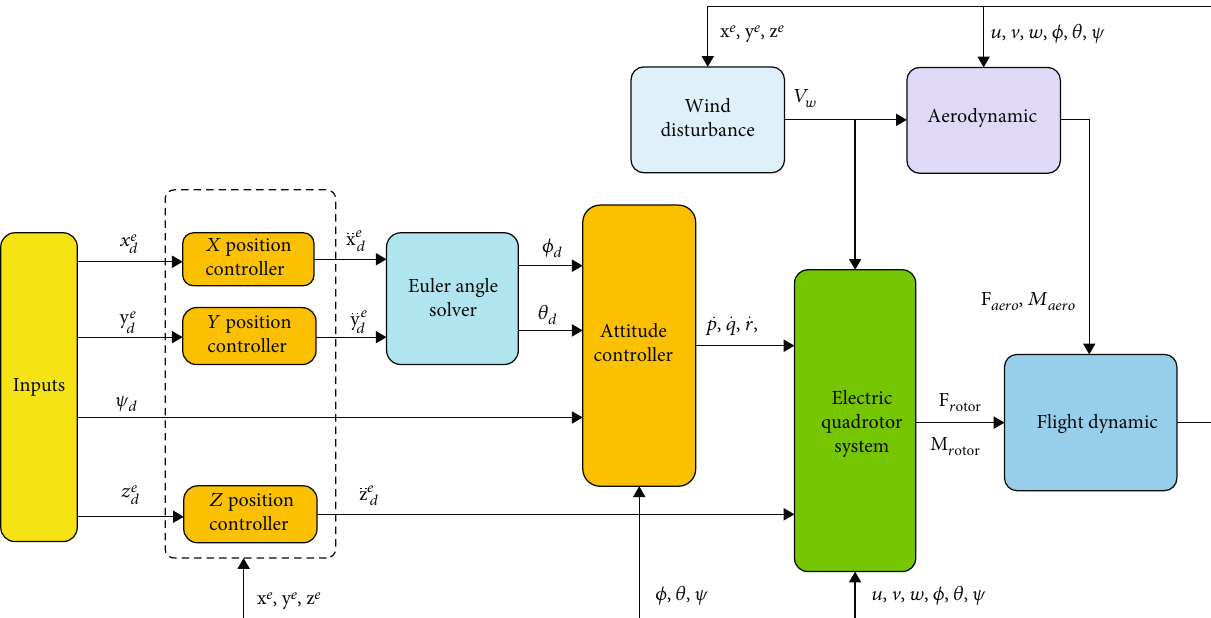
Figure 17: The fl ight simulation